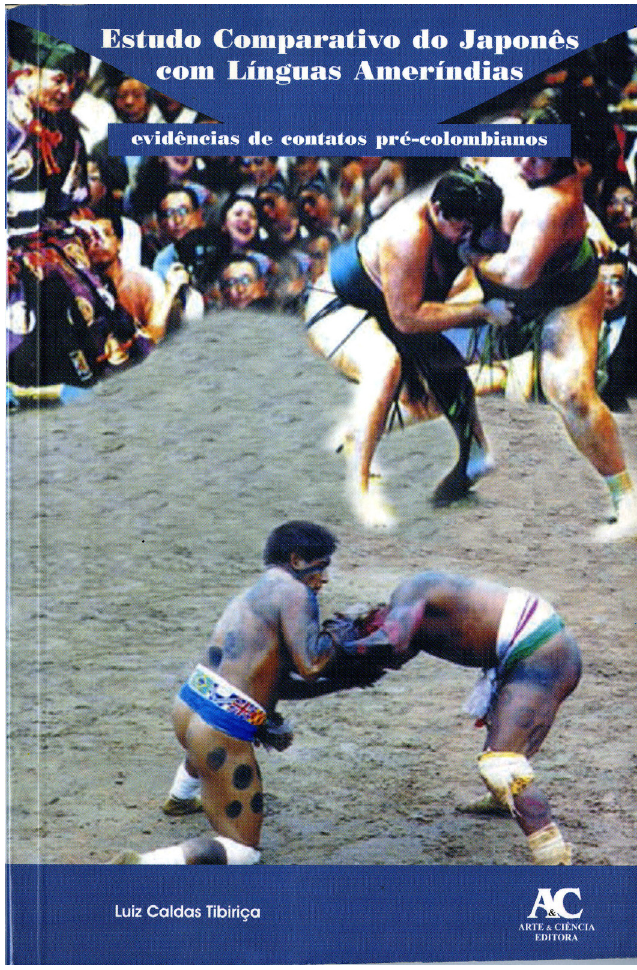
Figure 8. Huca-huca and Sumo